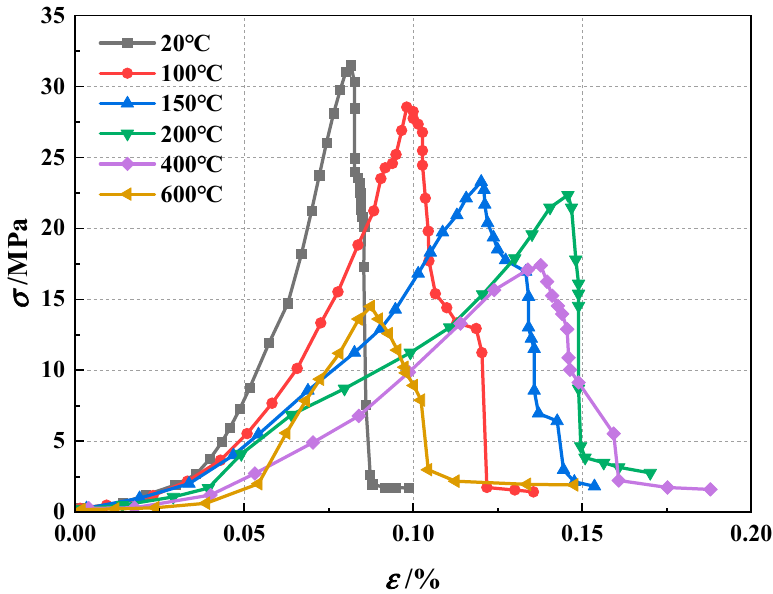
Figure 5. Compressive stress–strain curve of HSFCM after treatment at di ff erent